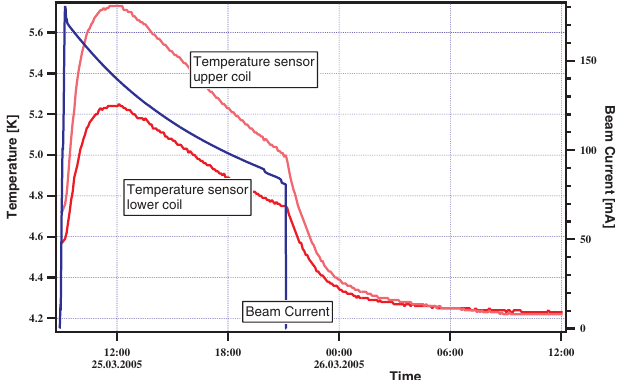
FIG. 4. (Color) Measured temperature change in the undulator device caused by the current (170 mA maximum beam current, beam energy 2.5 GeV).